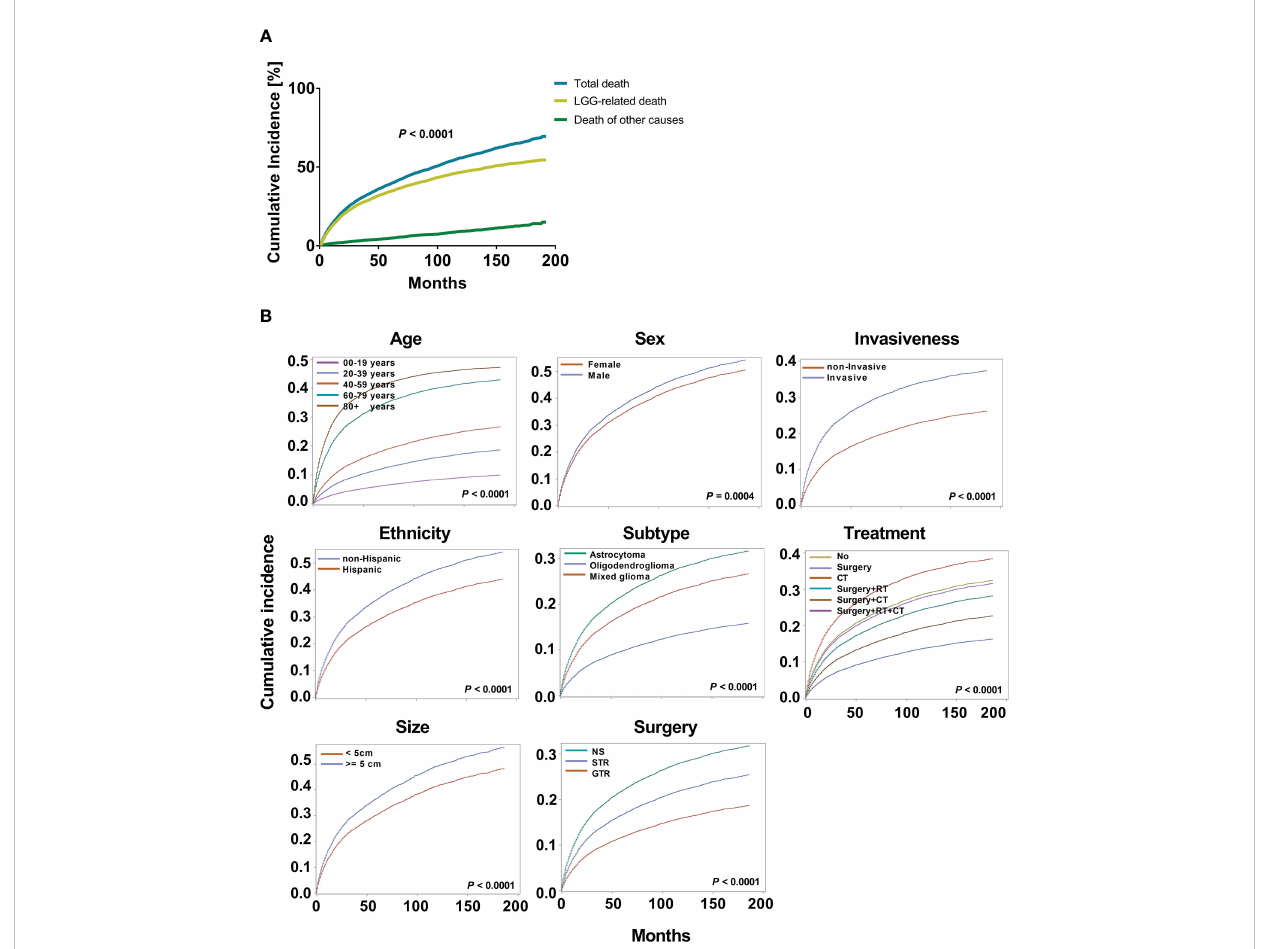
FIGURE 2 Cumulative incidence curves for low grade gliomas (LGGs). (A) . The cumulative incidence total death and death from LGGs and those from other causes. (B) . The cumulative incidence of tumor-related death was computed for each factor after accounting for the death of other causes. The subsequent plots present fraction of the population that has died from their LGGs by age, sex, ethnicity, histological subtypes, invasiveness, tumor size, surgery, and treatment